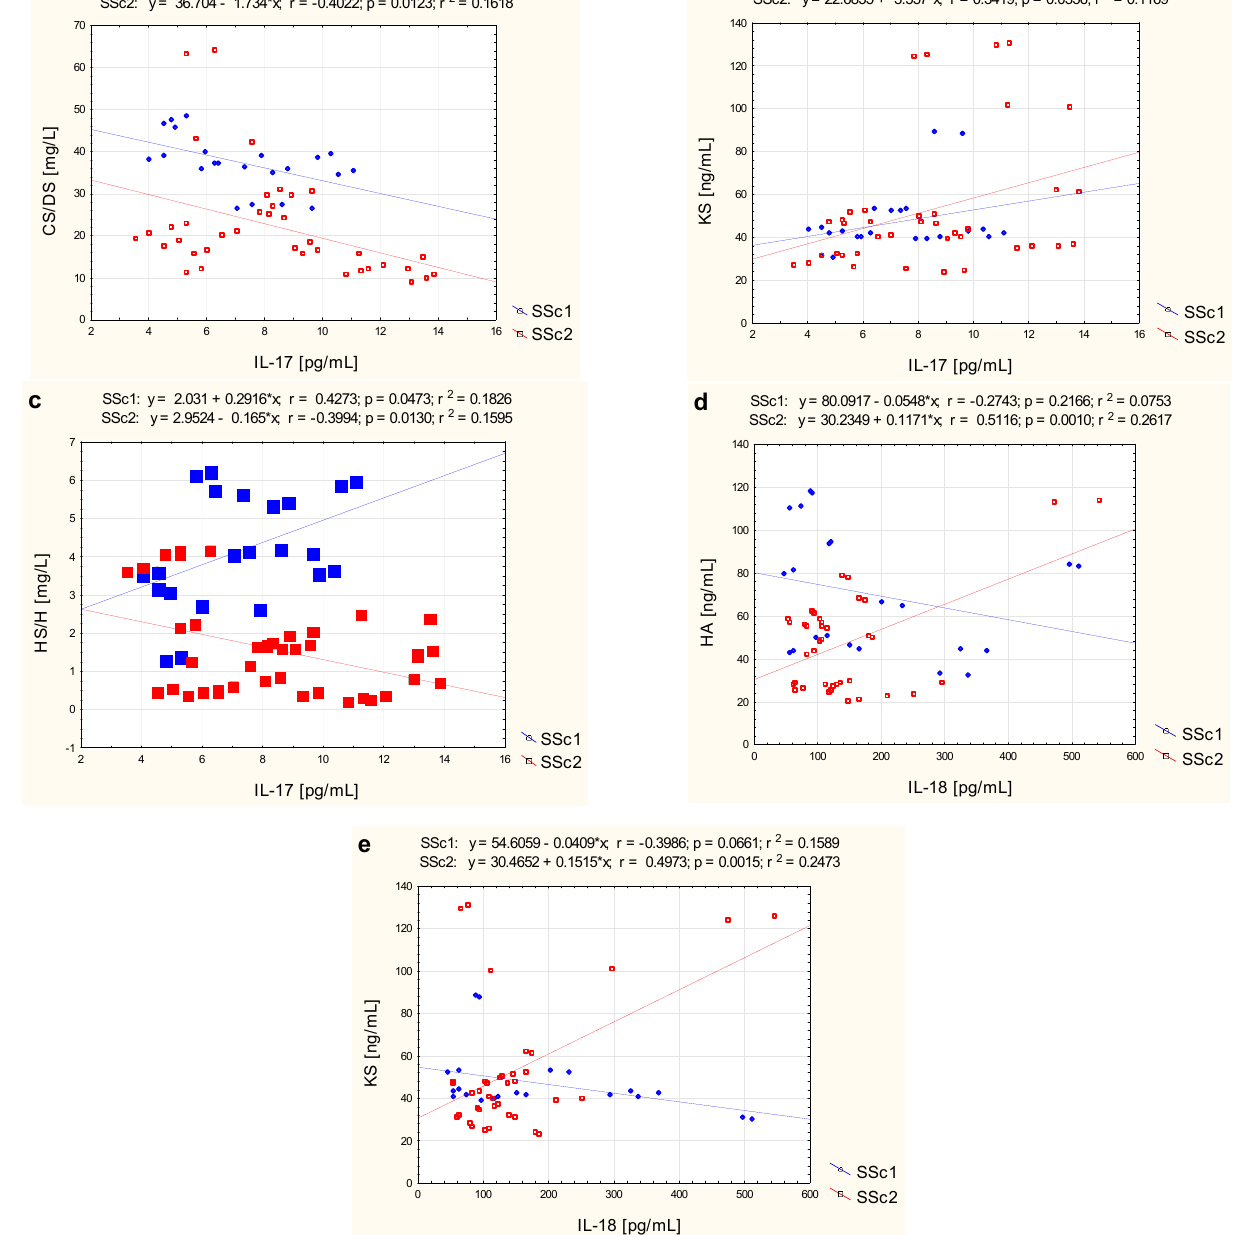
Figure 1. Correlation analysis between IL-17 and sequentially CS/DS ( a ), HS/H ( b ), and KS ( c ) and between IL-18 and sequentially HA ( d ) and KS ( e ) in the blood of patients with systemic sclerosis and normoalbuminuria (SSc1) or microalbuminuria (SSc2) presented as a scatter plot with fitted regression line.